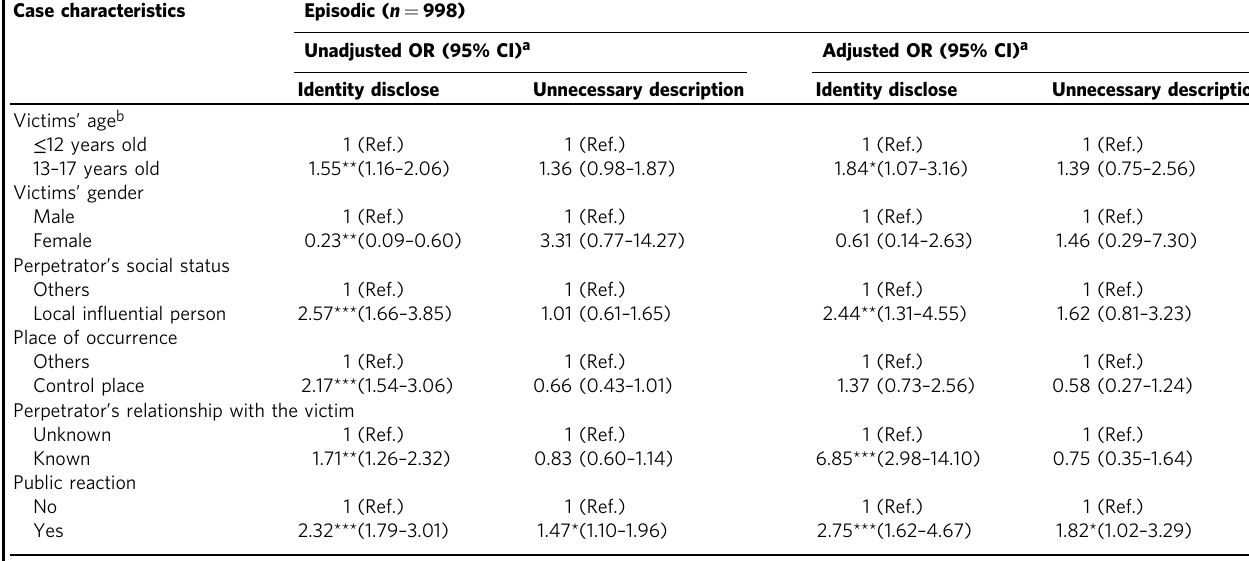
Table 3 Unadjusted and adjusted association (odds ratio) of CSA case characteristics with identity disclosure, and unnecessary description in episodic news